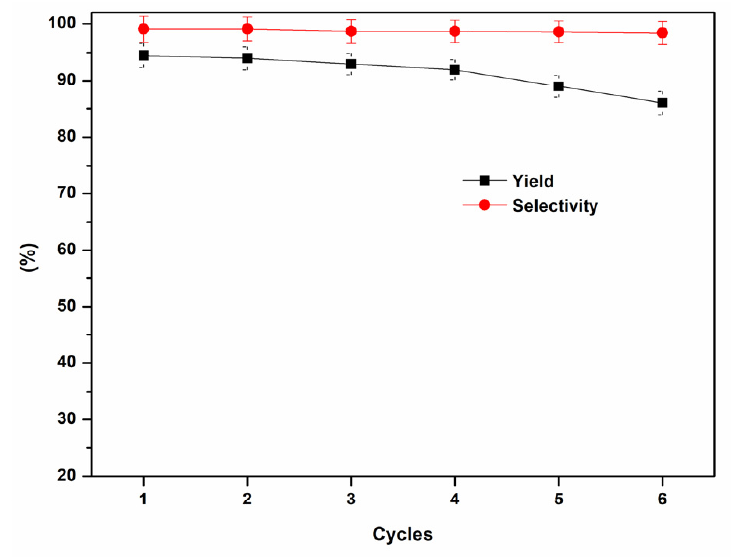
Figure 5. Recyclability study of solid catalyst MCM-41@ILLaCl 4 .